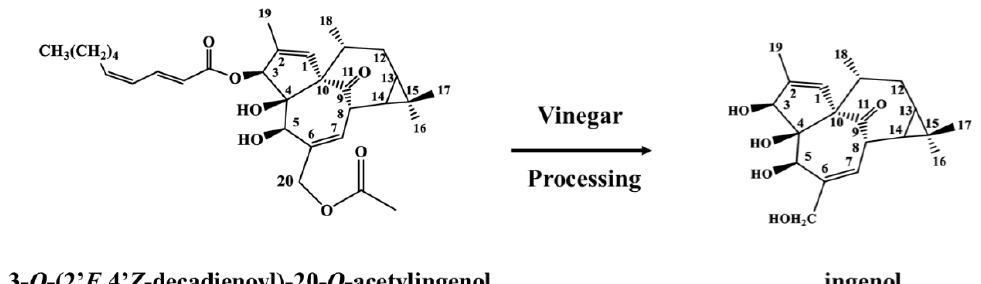
Figure 1. The conversion process between compounds 3-O-EZ and ingenol.